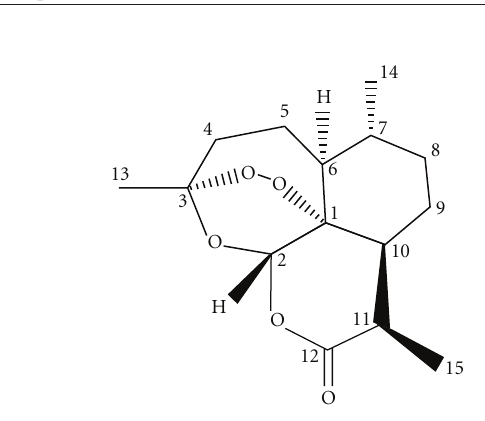
Figure 1: Structure of